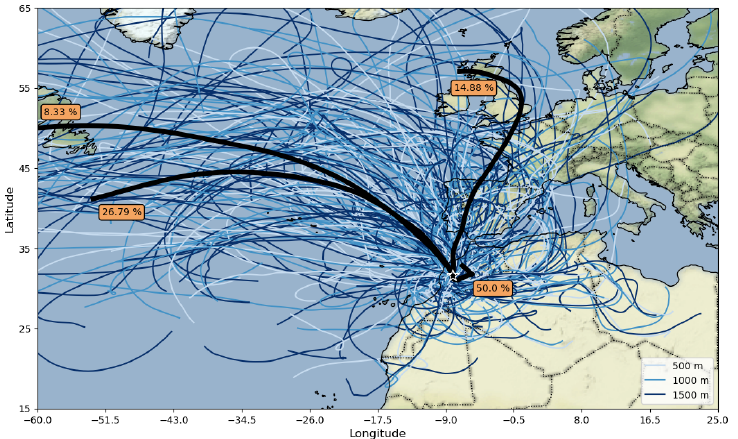
Figure 12. HYSPLIT climatological modelling showing the trajectories of aerosols located over Saada during winter from 2005 to 2020 for low height levels.